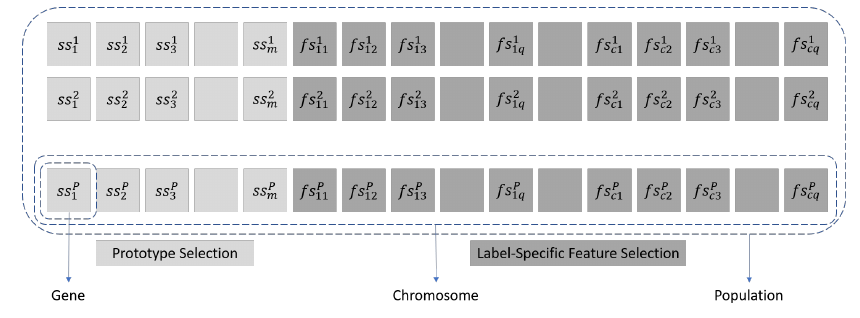
Figure 1. Gene, chromosome and population in evolutionary